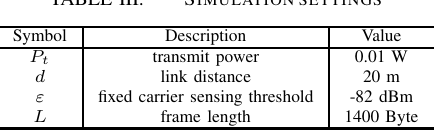
are distributed with PPP and the average number of senders is 50. The intended receiver is randomly located on the circle with a fixed radius of 20 m around the sender. The simulation time is 30 seconds and the results are calculated by an average of 10 runs with different random topologies. The simulations are conducted by Network Simulator 2 ( ns 2 ) with version − 2 . 35 . S IMULATION